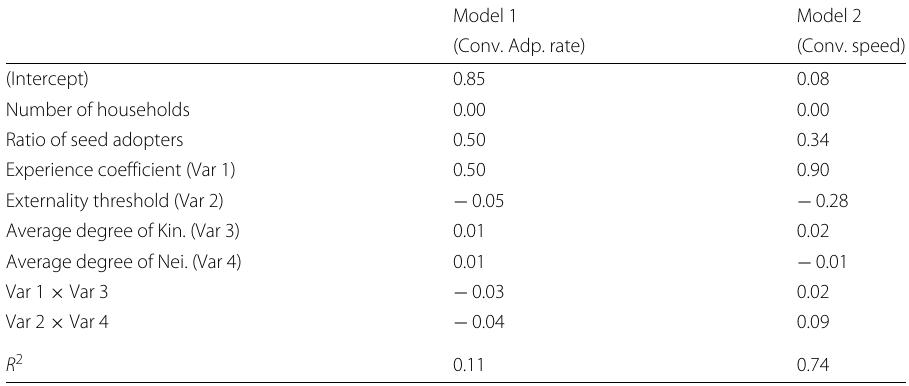
Table 7 Regressions of convergence adoption rate and convergence speed on average degree (negative externality effect)